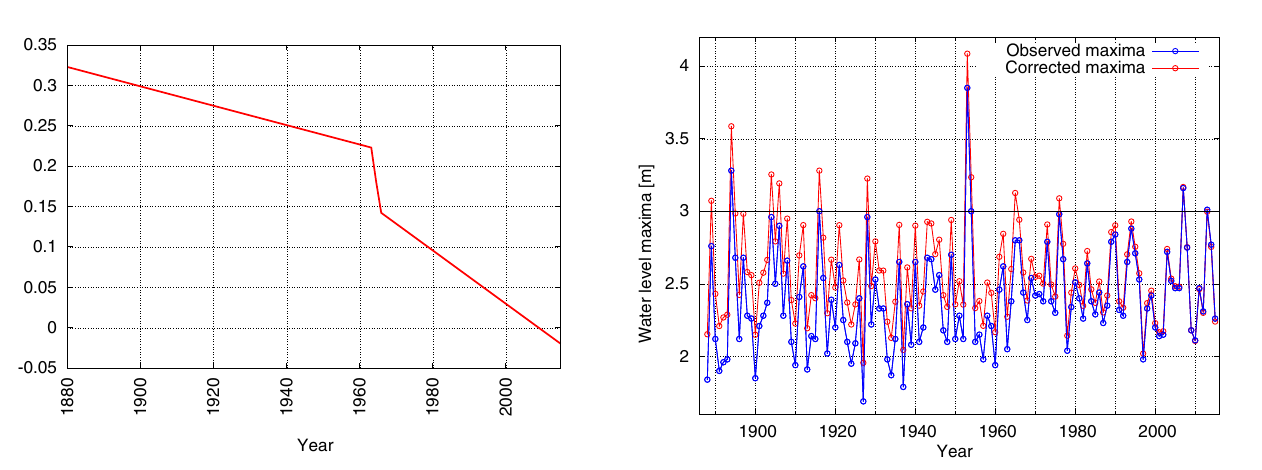
Figure 2. Annual maxima of the observed water levels in Hoek van Holland, 1887–2015 (blue). Correction according to Fig. 1 leads to the red